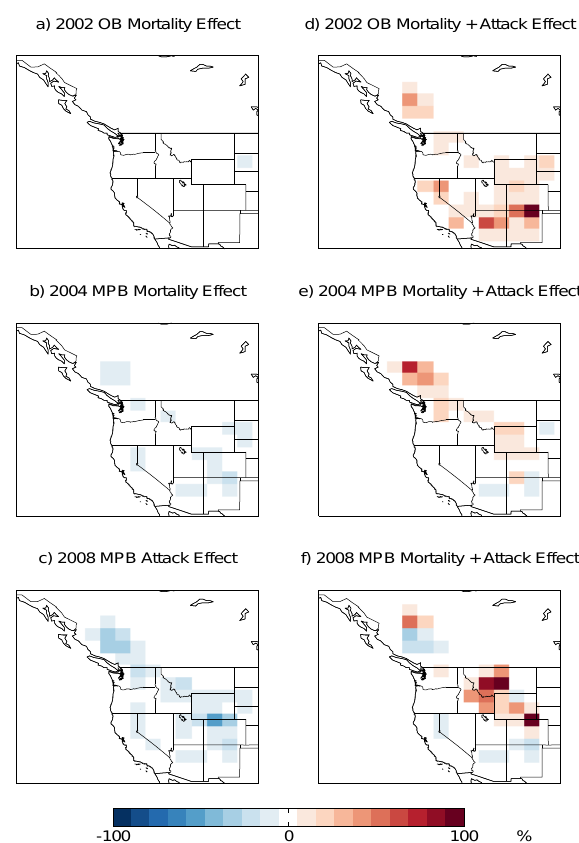
Fig. 5. Change in simulated summer-mean emissions of the four monoterpenes impacted by all beetles in 2002, 2004, and 2008. Change in emissions due to the mortality effect alone (a–c) and the mortality effect plus the attack effect (d–f) . Color bar is saturated at 100%.